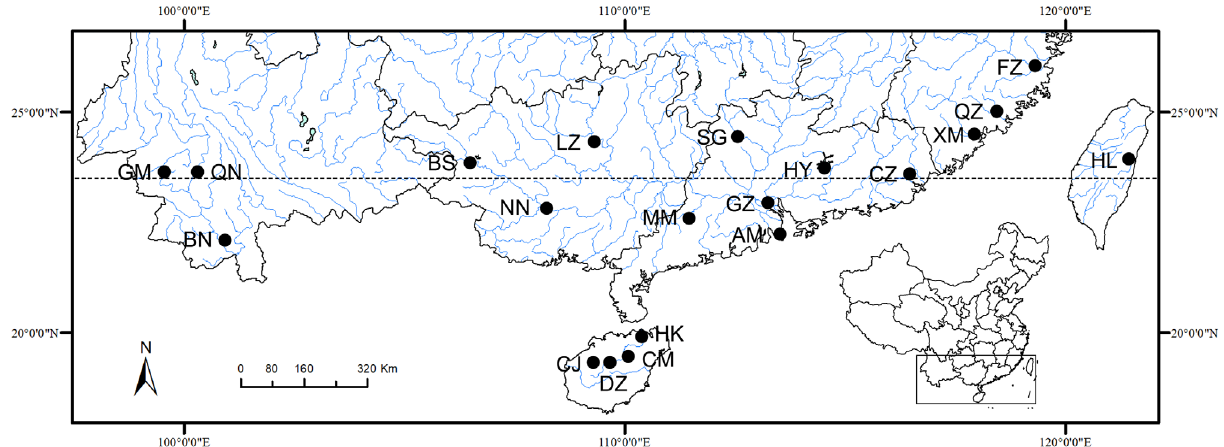
Figure 1. Map of investigation sites of tilapias in south China. AM natural preservation zone, Macau; BN Lancang River, Xishuangbanna, Yunnan Province; BS Boai River, Baise, Guangxi Province; CJ Shilu reservoir, Changjiang, Hainan Province; CM Jiatan reservoir, Chengmai, Hainan Province; CZ Han River, Chaozhou, Guangdong Province; DZ Songtao reservoir, Danzhou, Hainan Province; FZ Min River, Fuzhou, Fujian Province; GM Nongba reservoir, Lincang, Yunnan Province; GZ fi sh farm and pond in Sun Yat-sen University, Guangzhou, Guangdong Province; HK Nandu River, Haikou, Hainan Province; HL fi sh market, Hualien, Taiwan; HY Xinfengjiang reservoir, Heyuan, Guangdong Province; LZ Liu River, Liuzhou, Guangxi Province; MM Gaozhou reservoir, Maoming, Guangdong Province; NN Bachi River, Nanning, Guangxi Province; QN Lancang River, Lincang, Yunnan Province; QZ Jin River, Quanzhou, Fujian Province; SG Nanshui reservoir, Shaoguan, Guangdong Province; XM Xixi River, Xiamen, Fujian